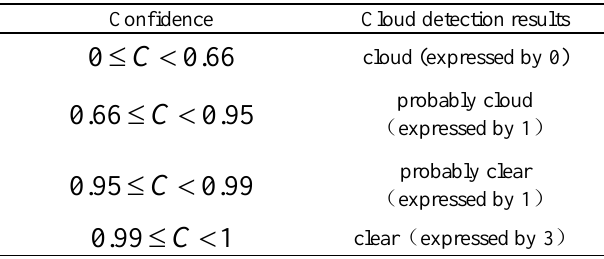
Table 5. Correspondence between confidence and cloud detection